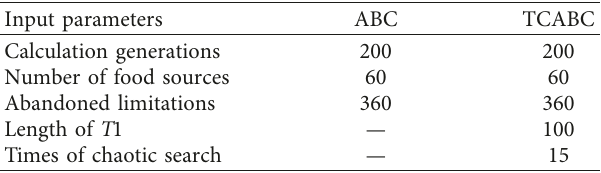
Figure 7: Influences of the length of T 1 for TCABC algorithm. Table 4: Input parameters of the damage